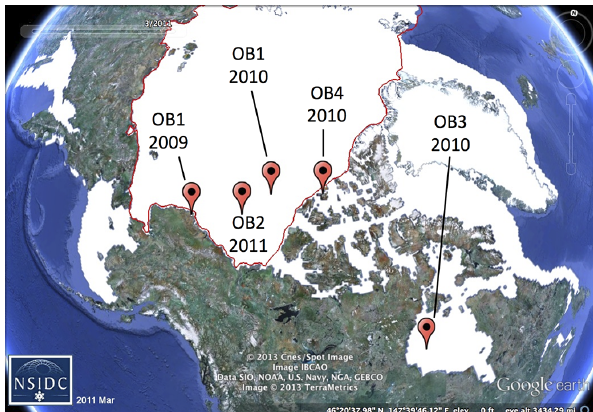
Figure 1. Map of locations at which various O-Buoys (abbreviated OB) were deployed between 2009 and 2011. For the coordinates, see Table 1. Sea ice extent image is for the month of March 2011. Map courtesy of Google Earth, and sea ice image courtesy of the National Snow and Ice Data